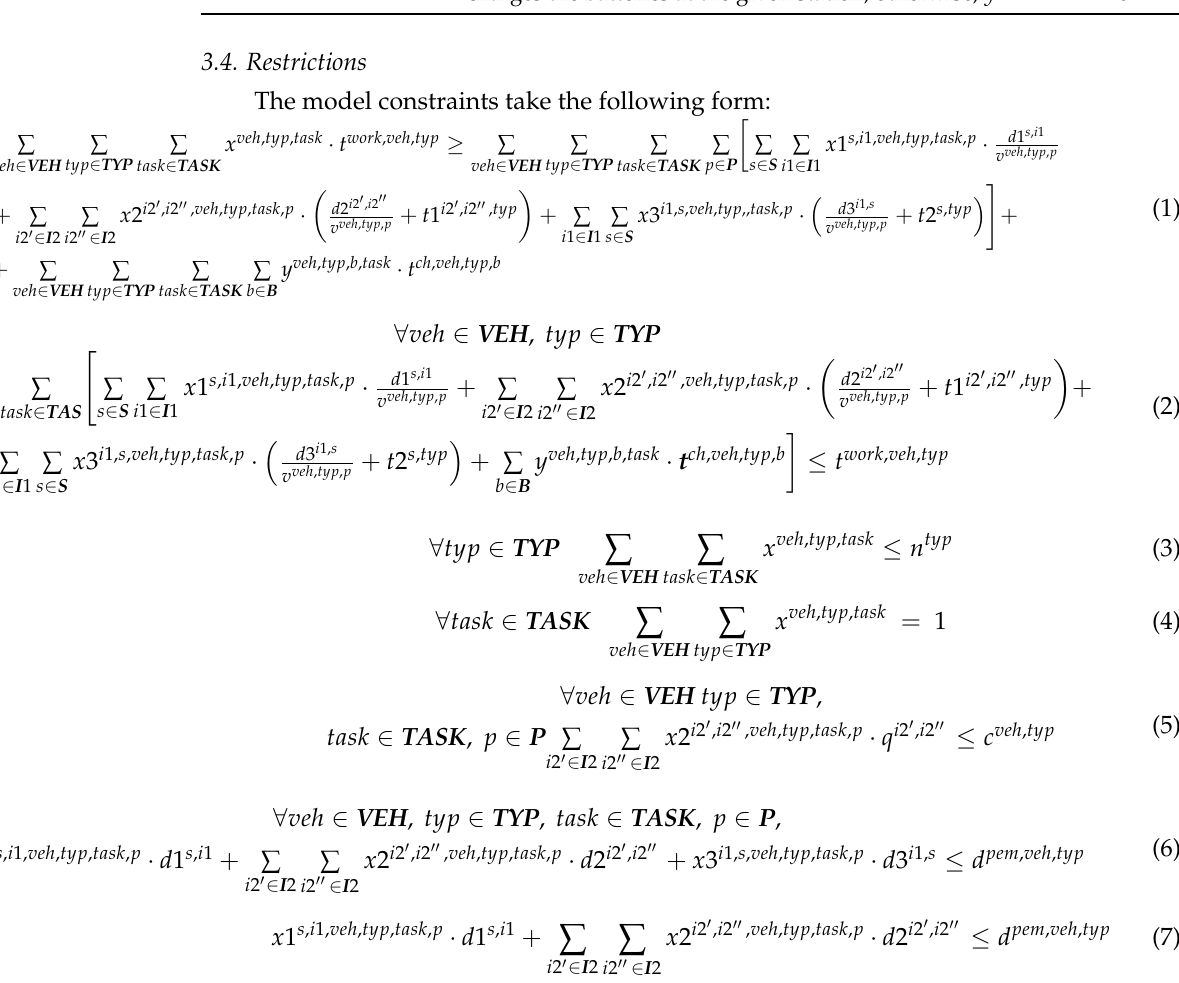
Table 2. Cont. Symbol Meaning A connection between a route intermediate point and a collective point made by a vehicle of a given type during a given period of the day in the task in progress, where X3 is a matrix defining all these connections. If x 3 i 1 ,s,veh,typ,task,p x 3 i 1 ,s,veh,typ,task,p = 1, the vehicle of the type performs the route between the intermediate point and the collective point; otherwise, x 3 i 1 ,s,veh,typ,task,p = 0. Making a decision to charge a vehicle at a given station in a task in progress, where Y is a matrix specifying all decisions made to charge y veh,typ,b,task vehicles at given stations. If y veh,typ,b,task = 1, the vehicle of the given type charges the batteries at the given station; otherwise, y veh,typ,b,task =